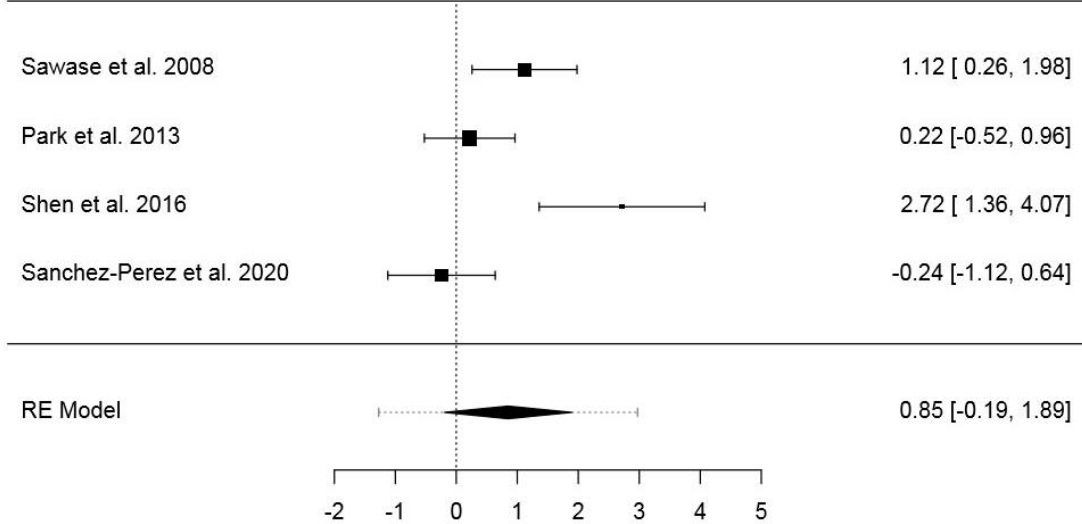
Figure 6. Forest plot for the random-effects model with the DerSimonian – Laird estimator in the fourth dataset (effects size: standardized mean difference of the bone – implant contact).